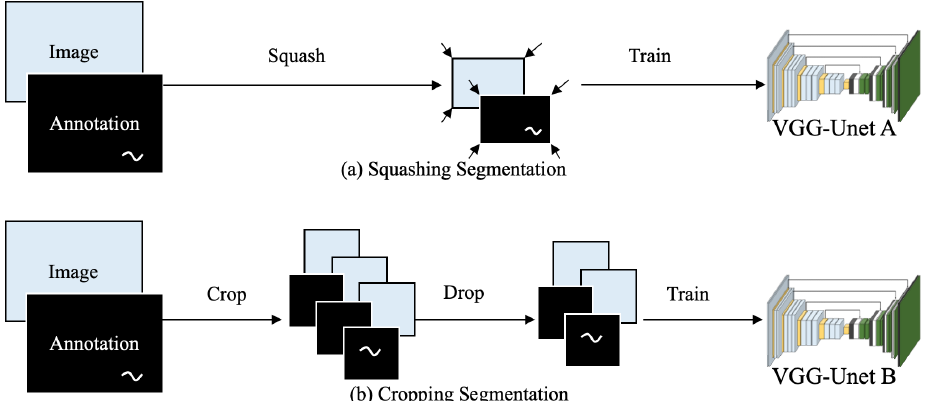
Figure 6. The training process of Damage